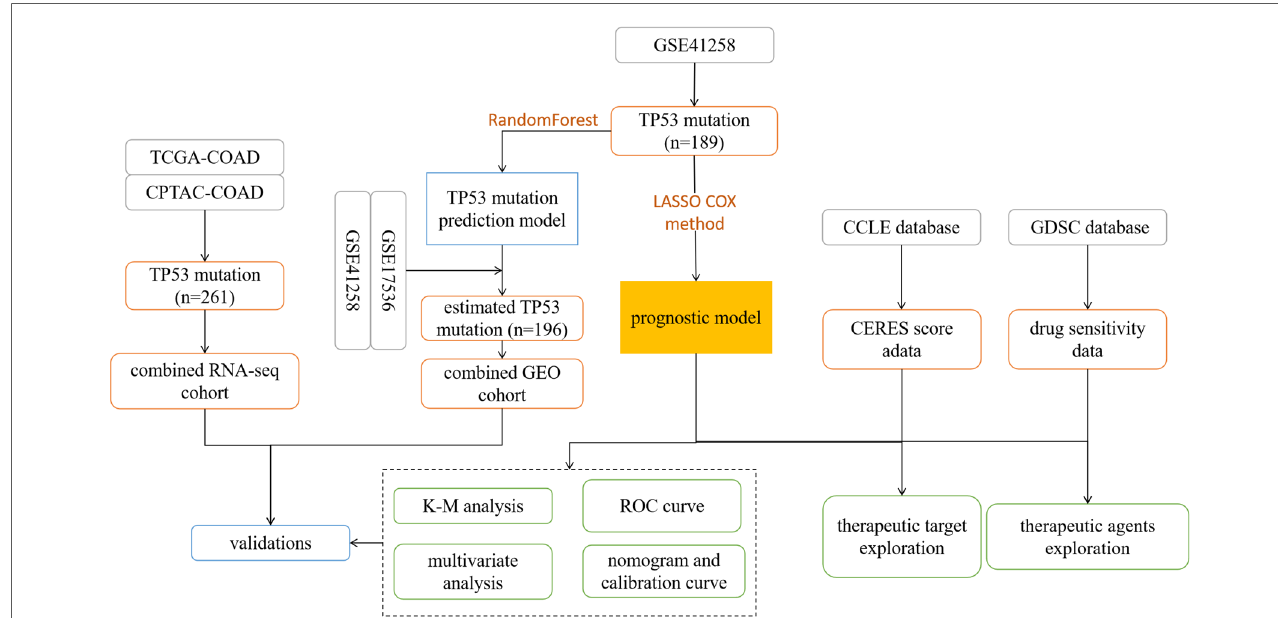
FIGURE 1 The fl ow chart for this